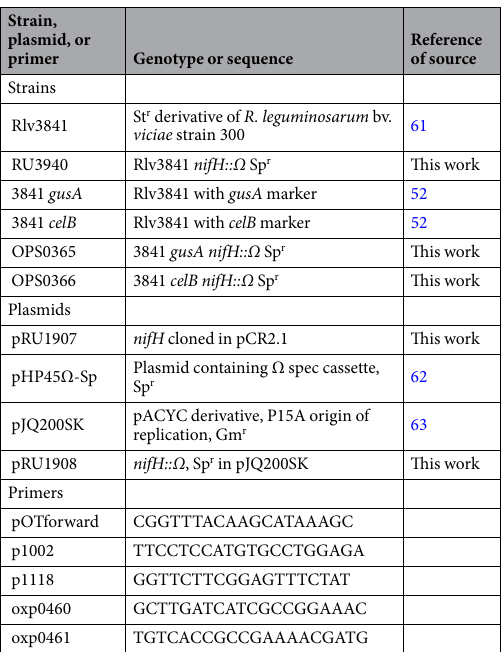
Table 1. Strains, plasmids and